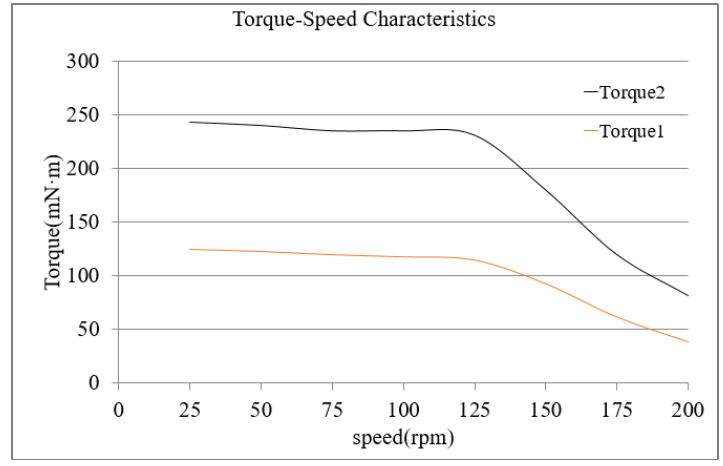
Figure 9. Torque-speed characteristics